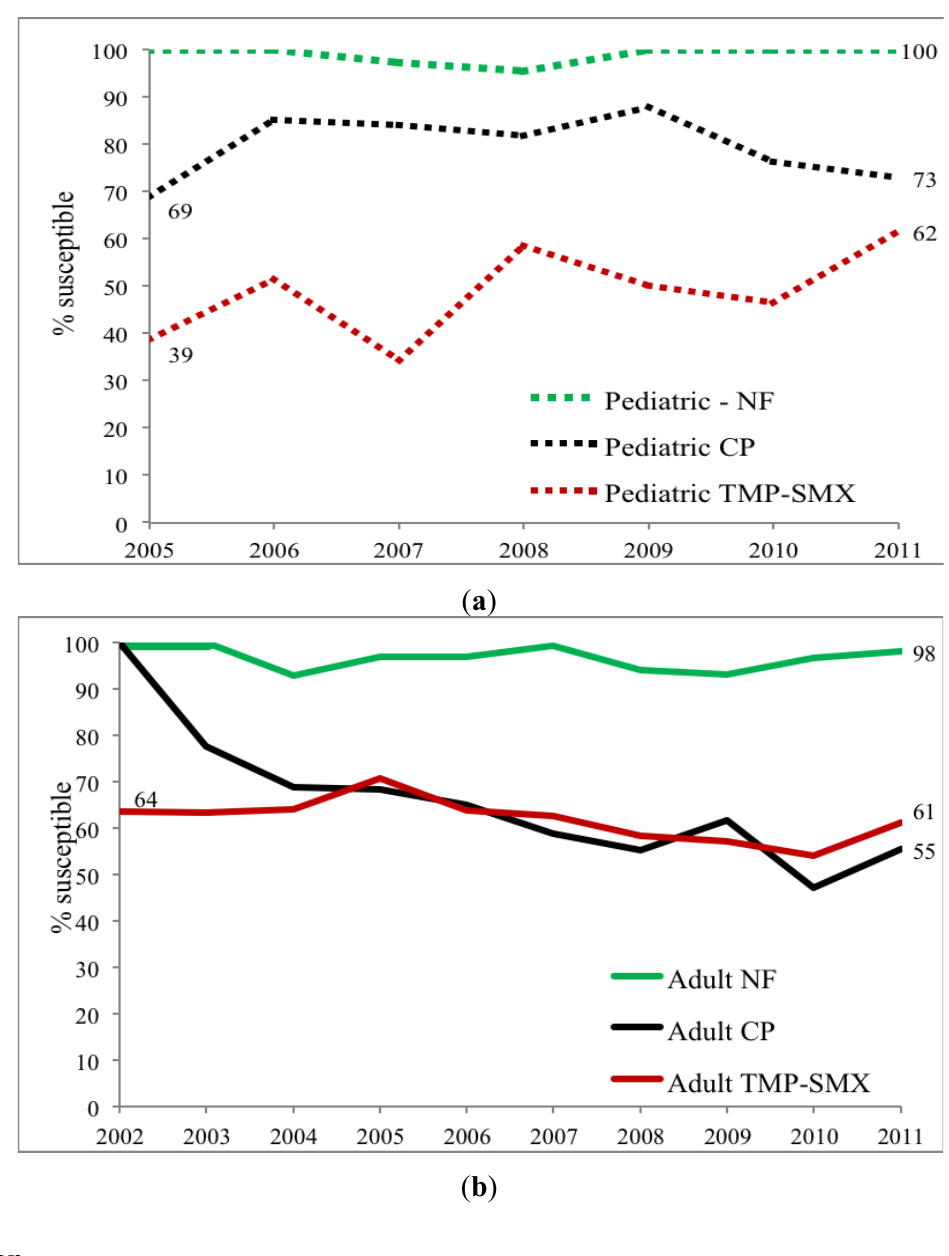
Figure 5. ( a ) Pediatric urology clinic susceptibility trends for three commonly prescribed antimicrobial agents for E. coli positive urinary cultures (NF = nitrofurantoin, CP = ciprofloxacin, TMP-SMX = trimethoprim-sulfamethoxazole); ( b ) Adult urology clinic susceptibility trends for three commonly prescribed antimicrobial agents for E. coli positive urinary cultures (NF = nitrofurantoin, CP = ciprofloxacin, TMP-SMX =